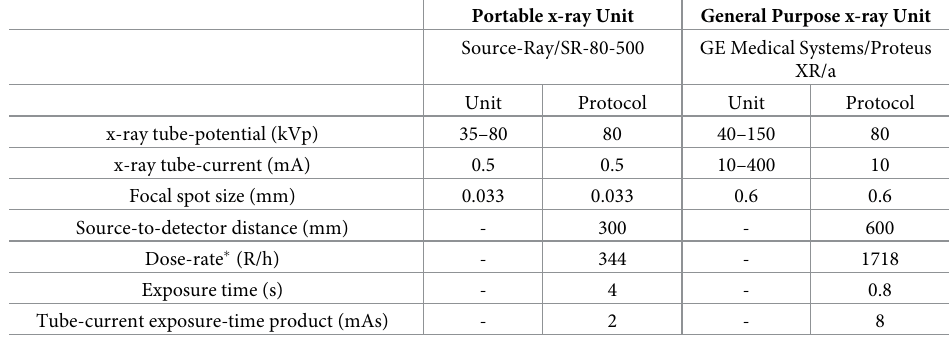
� Dose-rates were calculated using Rad Pro Calculator version